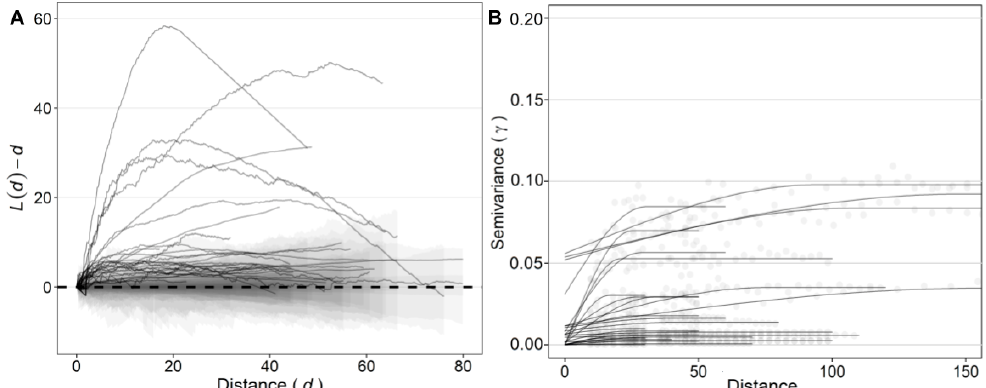
Figure 6. Distance-based statistics of the incidence of Fusarium wilt of banana in 30 fields in Brazil. ( A ) L ( d )- d against d (solid line), superimposed envelopes (shaded area) and the random pattern (dashed line) are presented. ( B ) Semivariance ( γ ) in a range of distances was represented by spherical model fitted to the data. Fields were represented by solid lines. Distances are presented in meters (m).